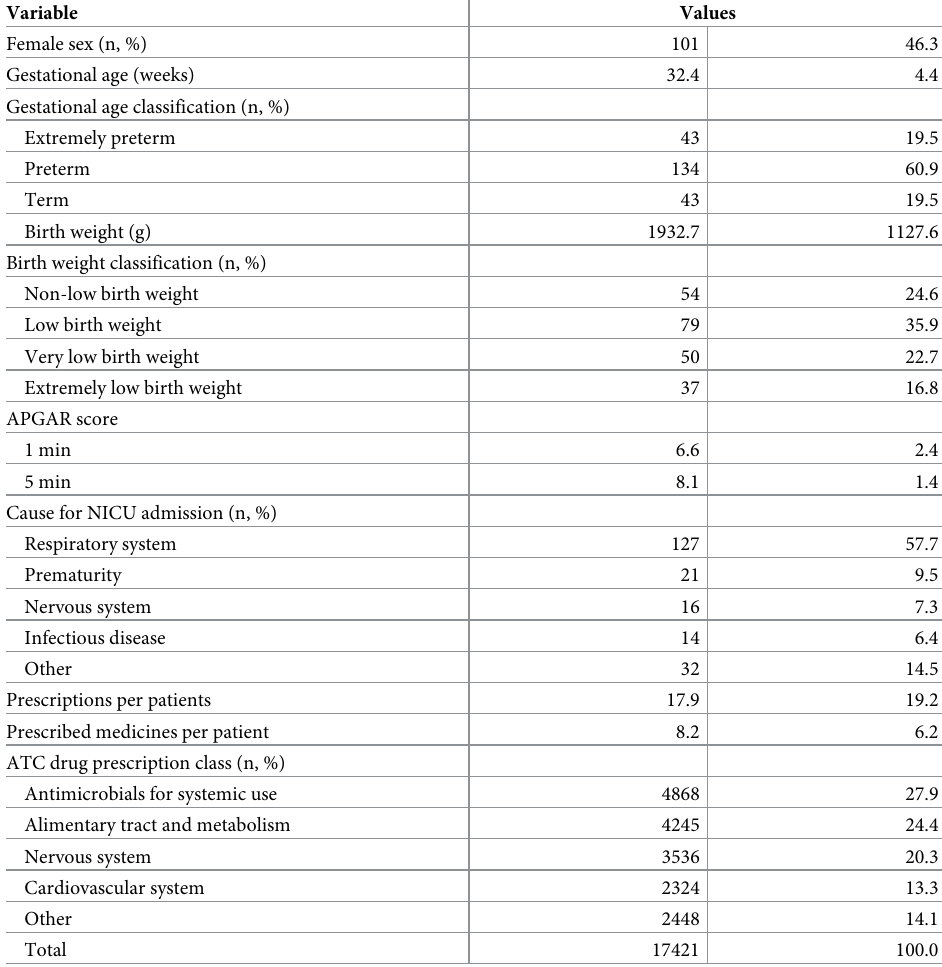
Table 1. Patient caracteristics of the study population.